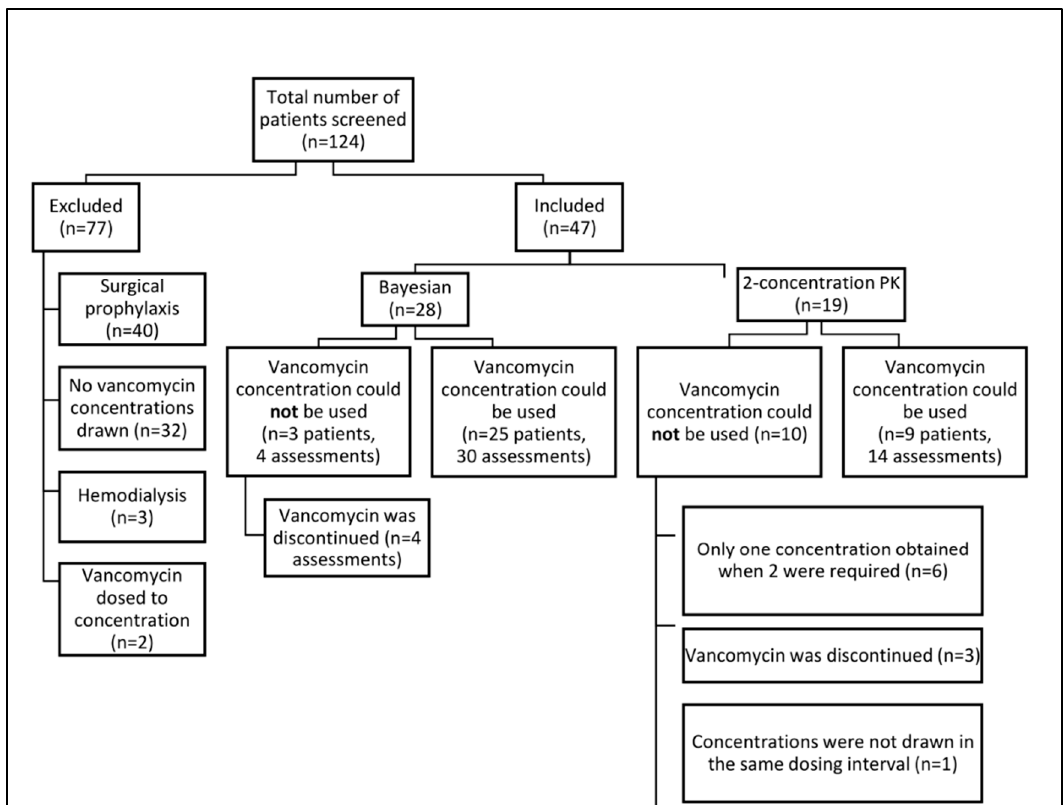
Figure 3. Flow diagram for patient enrollment and inclusion and exclusion criteria. Table 1. Baseline characteristics.